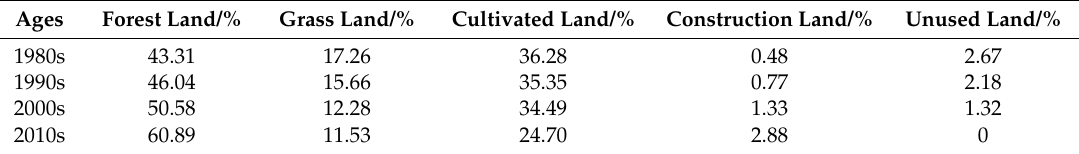
Table 1. Land use information in different stages.